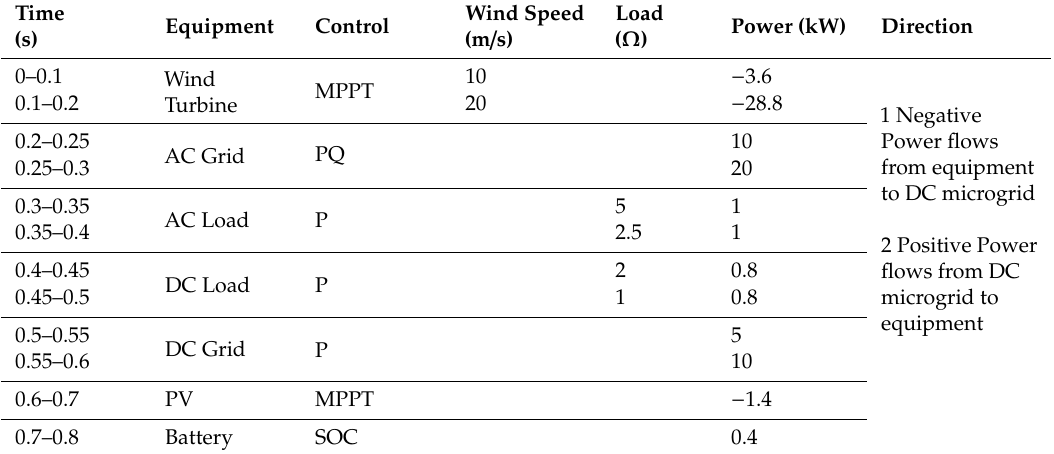
Table 6. Simulation State Parameters.